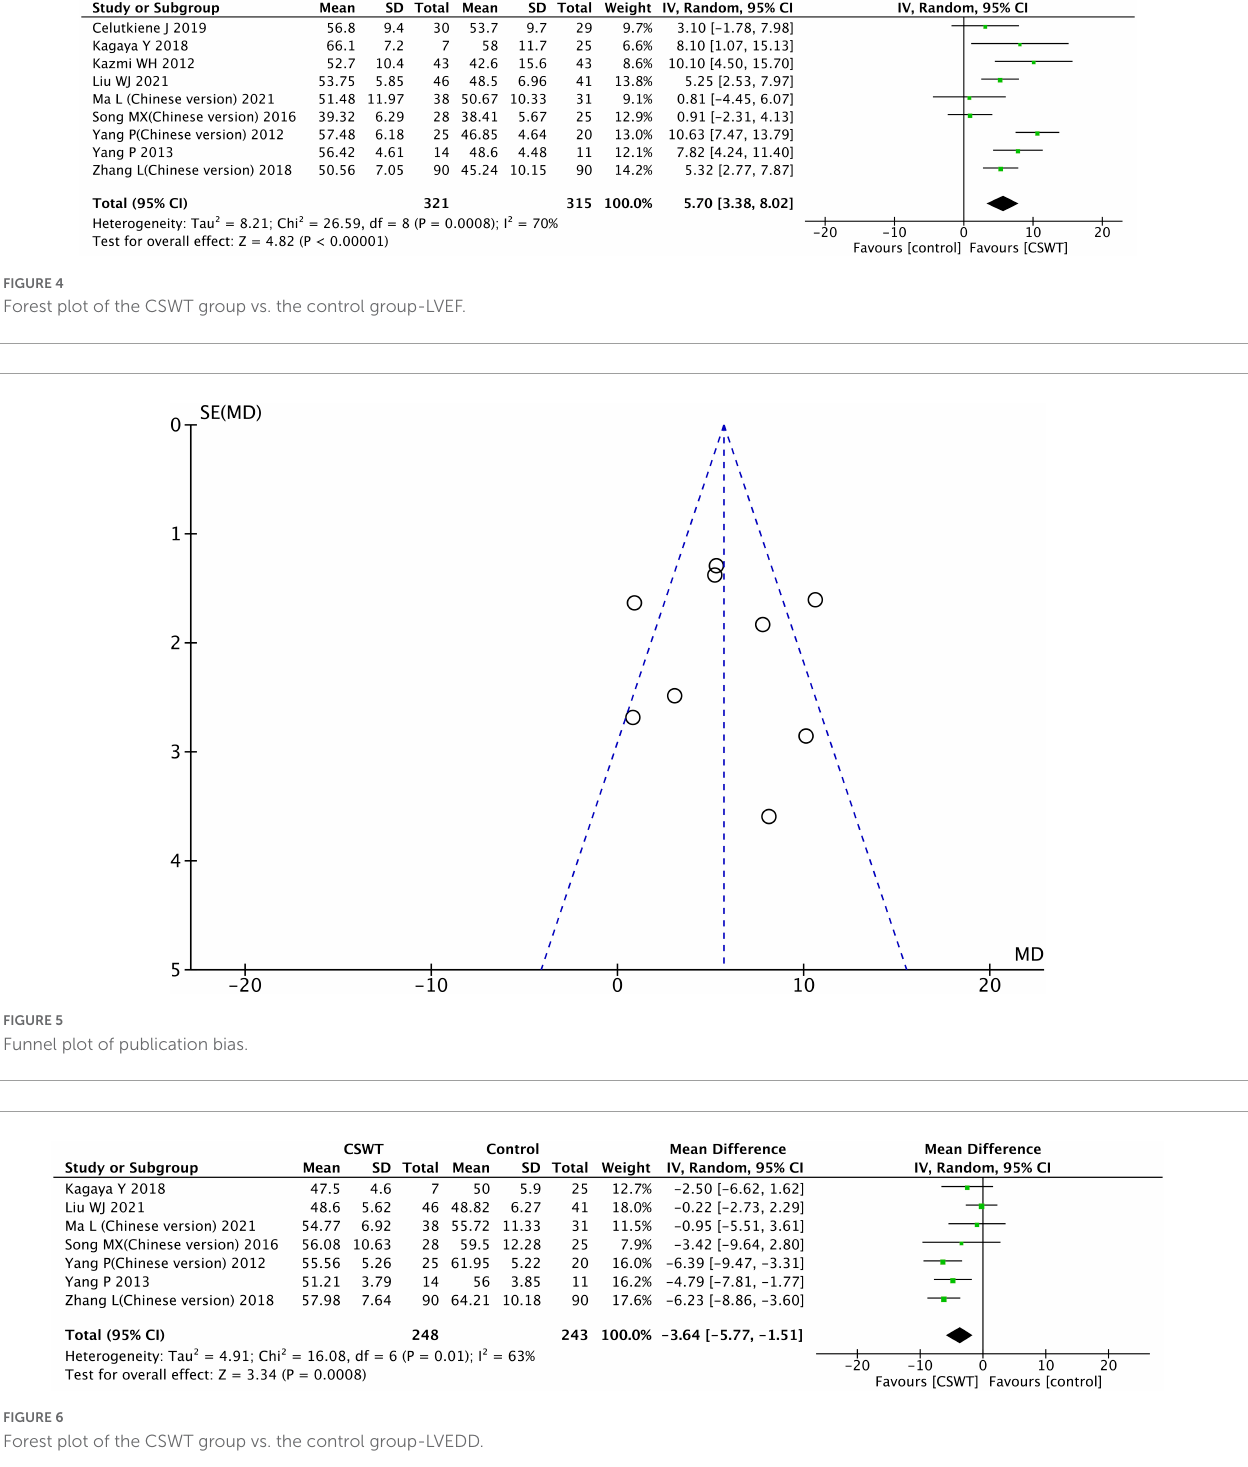
recruitment of progenitor cells to the site of the ischemia undergoing CWST (30, 31). In light of these, the positive benefits of CWST are likely the result of several angiogenic mechanisms